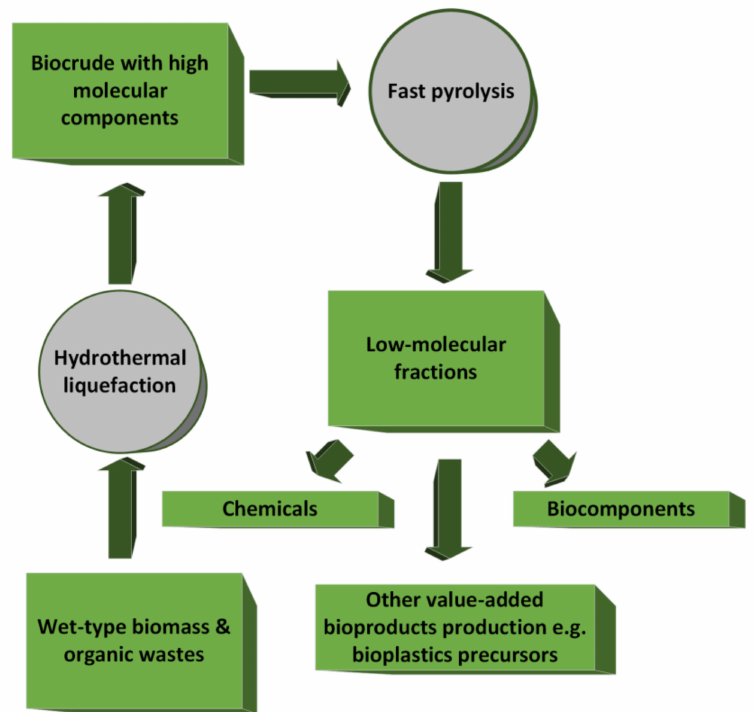
Figure 1. The proposed approach for two-stage processing of waste fruit pomace via hydrothermal liquefaction followed by the fast pyrolysis of biocrude toward value-added